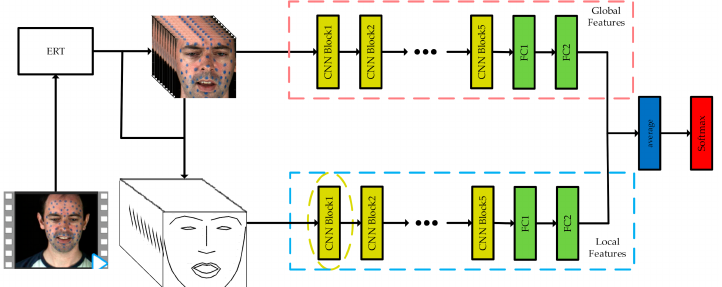
Figure 3. The proposed MC-DCN network architecture. The face data are divided into a face part and a local feature part. They are sent to two identical parallel networks, which are finally connected to an average pooling layer. the CNN block will be introduced in detail in Section